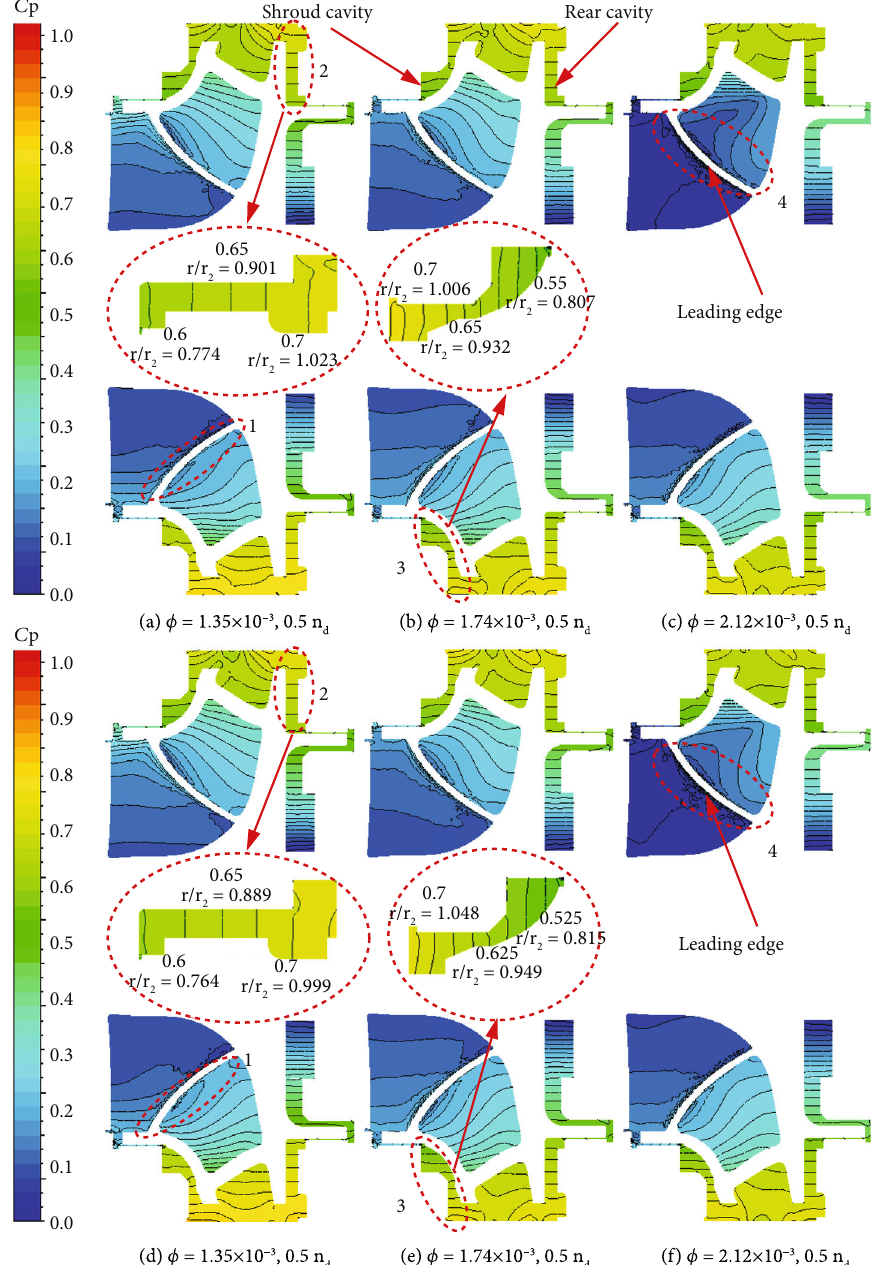
Figure 12: Comparison of the pressure fi eld under di ff erent rotational